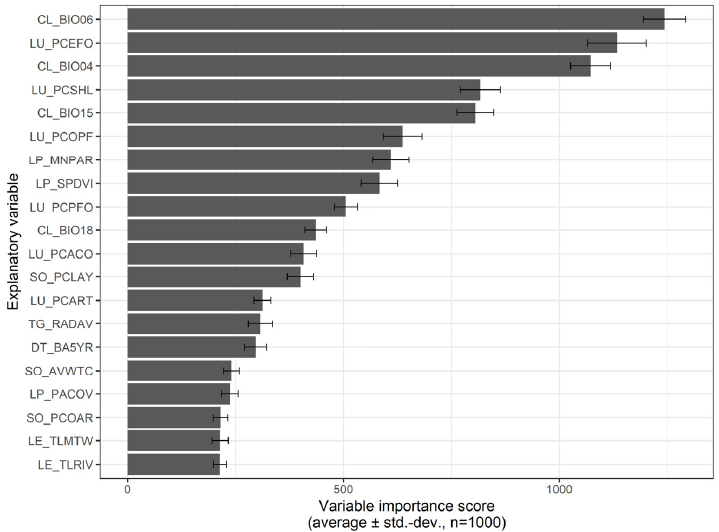
Figure 6. Importance scores for the 20-selected predictive variables calculated from the Random Forest model. Average (grey bars) and standard deviation values (‘whiskers’) are presented for the 1000 rounds performed with the random forests algorithm. Acronyms for predictor variables are presented in Table 2.